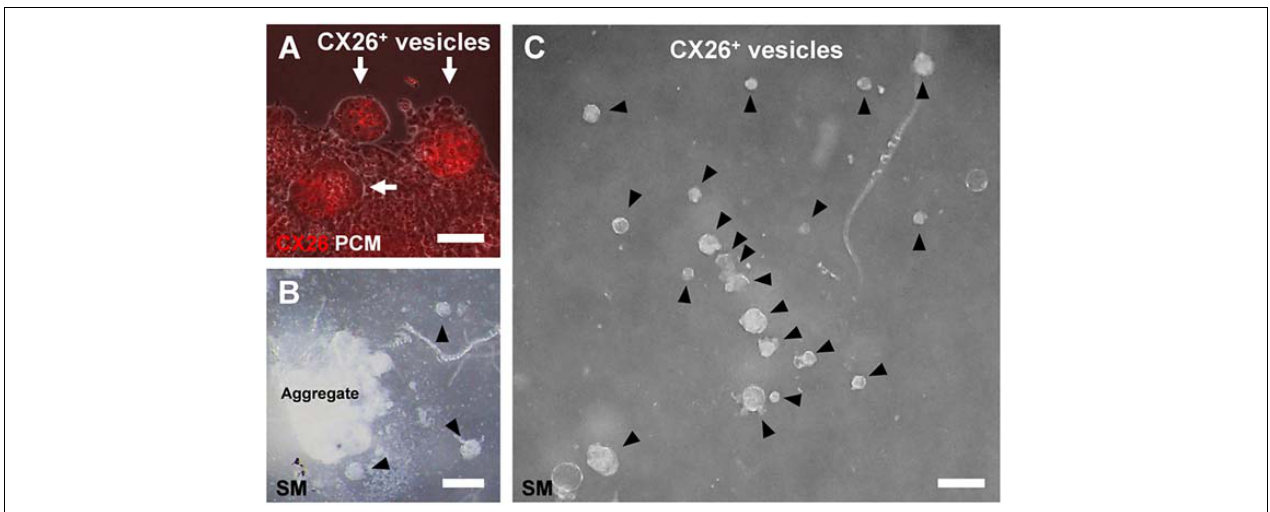
FIGURE 4 | CX26 + vesicles in aggregates with BMP4 and SB supplementation. (A) Merged images from fluorescence microscopy of CX26 immunostaining (red) and phase-contrast microscopy (PCM, white) of ESC aggregates at day 7. Arrows point to CX26 + vesicles containing CX26GJCs. (B,C) Stereomicroscopic (SM) images of isolated CX26 + vesicles from ESC aggregates at day 7. Arrowheads point to CX26 + vesicles. CX26 + vesicles were easily isolated from partially dissected ESC aggregates (B) and then were mechanically collected (C) . Scale bars: 50 µ m (A) , 100 µ m (B,C) .